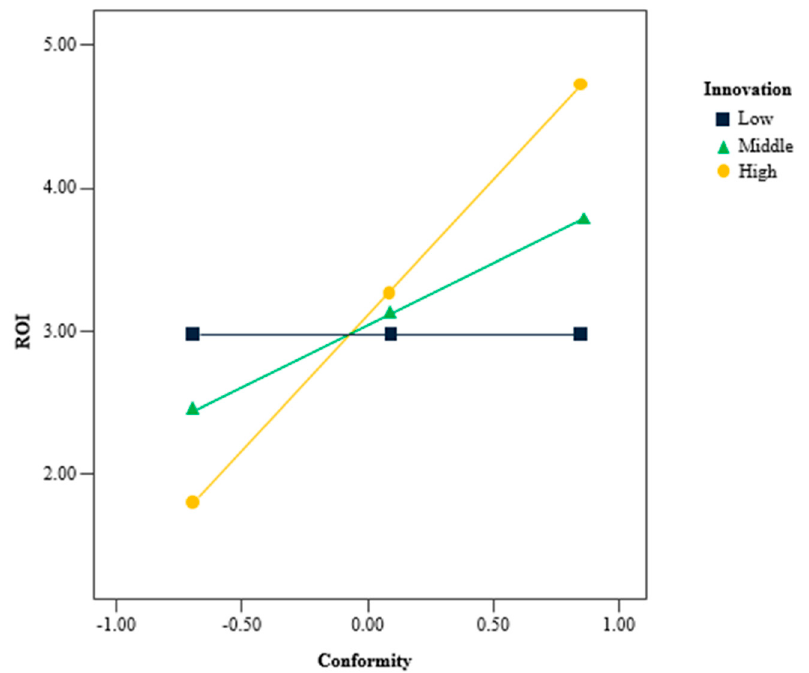
Figure 2. Conditional effect of strategic conformity and performance at three different levels of innovation interaction.